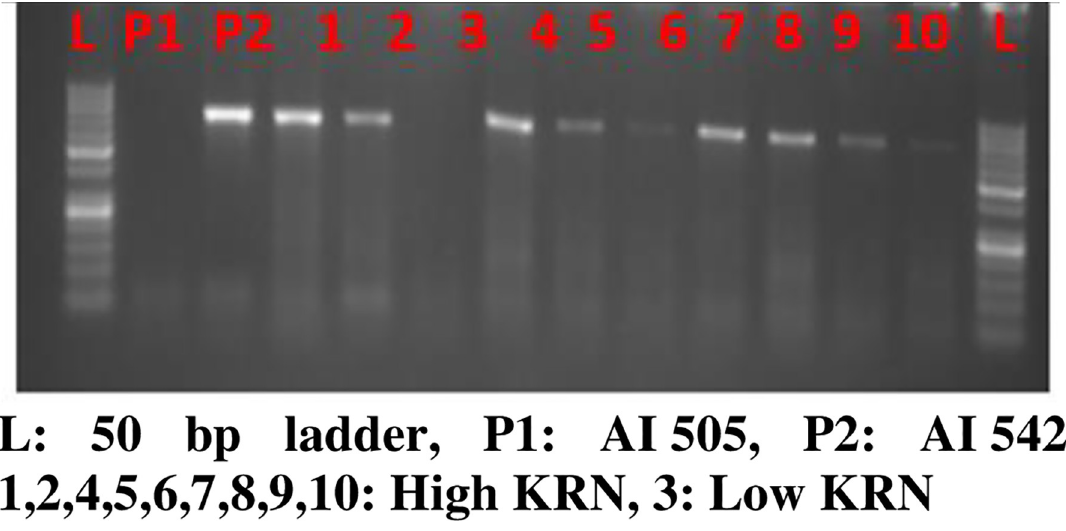
Fig 5. Validation of novel primer 1311fea2.1 in 155 F 2 progenies.